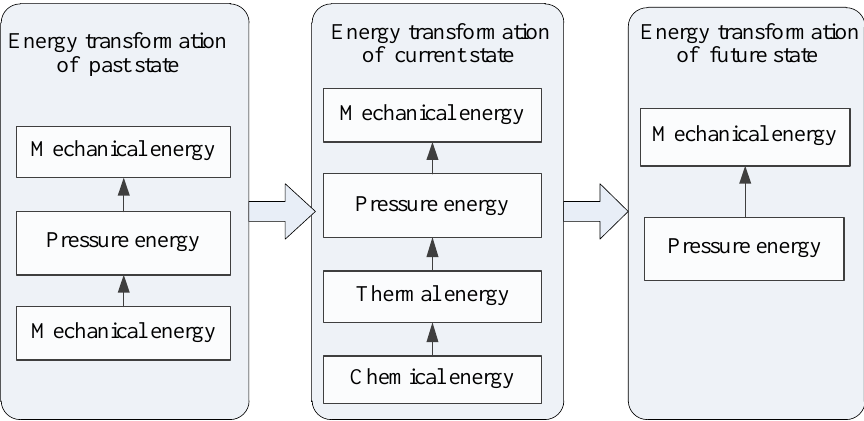
Figure 8. Analysis of the evolutionary direction of engine subsystem.